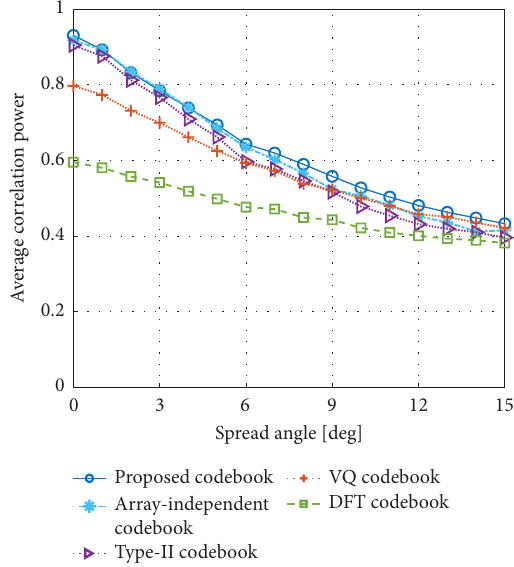
Figure 12: Correlation power performance comparison of the proposed and exiting codebooks under channel conditions with varying spread angles.